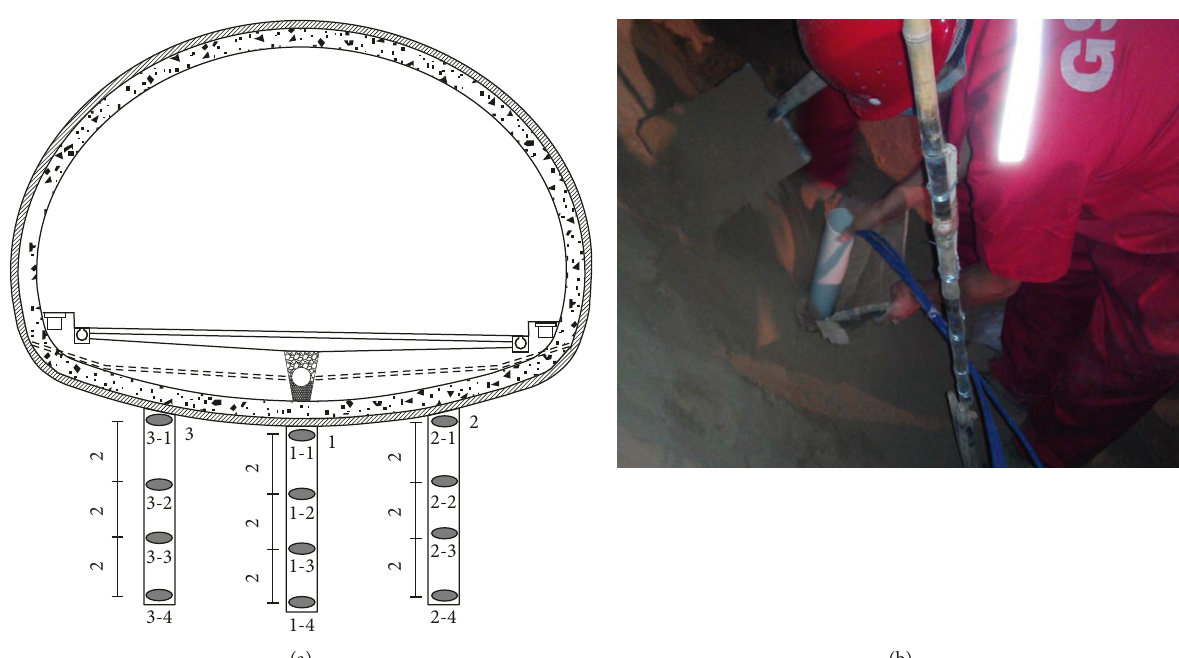
Figure 6: Layout of the earth pressure cells.